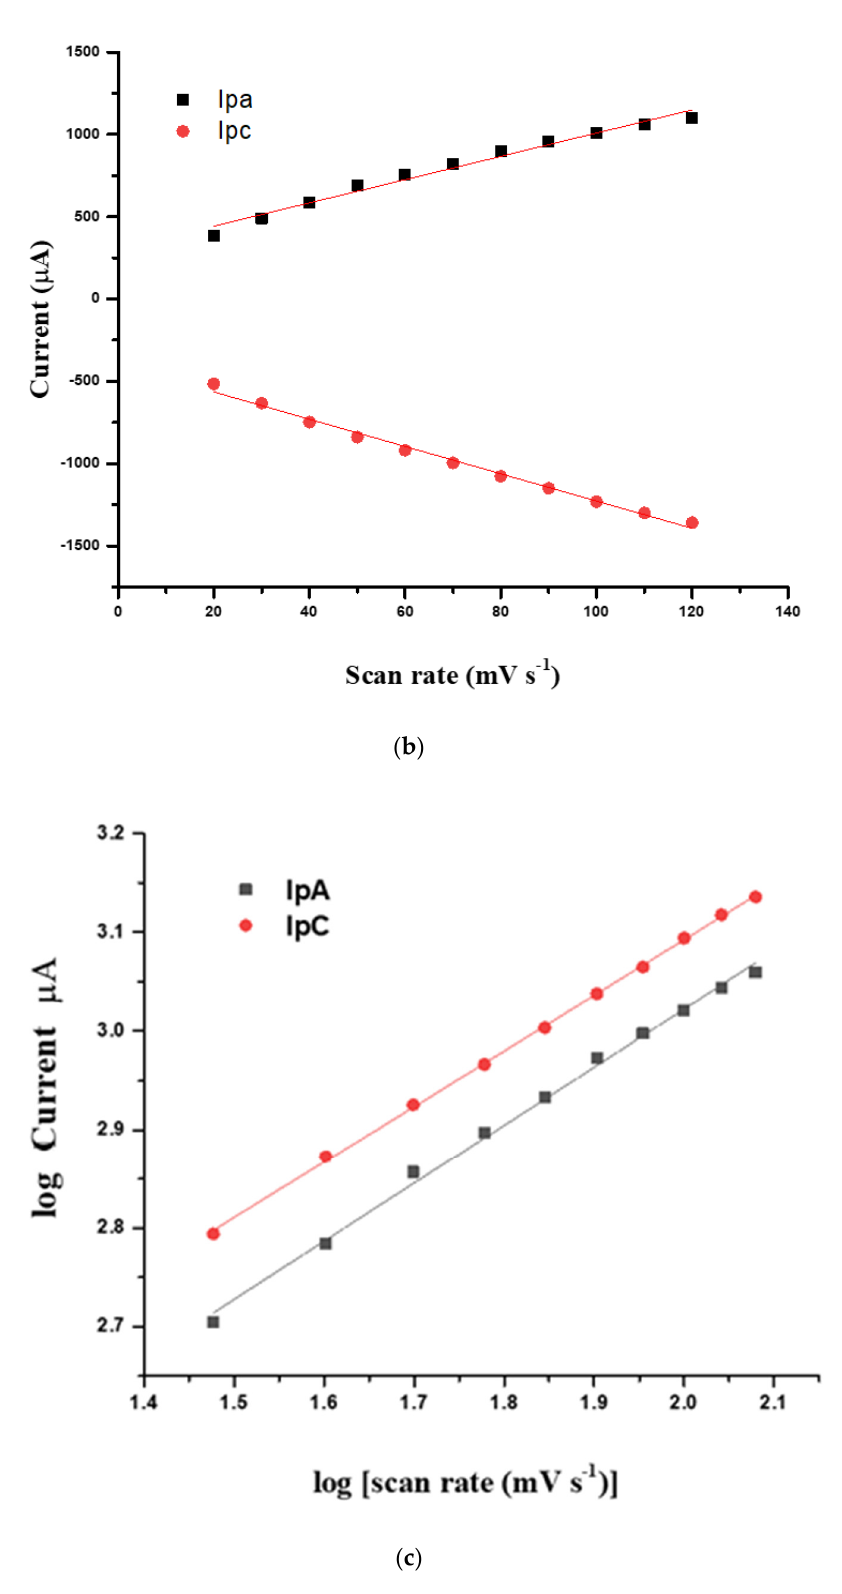
Figure 5. ( a ) CVs obtained from the CHI–CNT@PB film at 20, 30, 40, 50, 60, 70, 80, 90, 100, 110, and 120 mV · s − 1 scan rates (inner to outer); ( b ) plot of anodic and cathodic peak currents from CVs vs. square root of scan rate; ( c ) plot of log Ipa and Ipc vs. log scan rate. All measurements were performed in KCl (100 mmol · L − 1 ) as the supporting